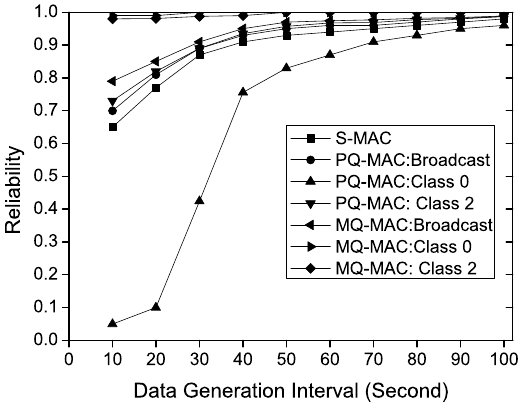
Figure 10. Reliability for different data generation interval.